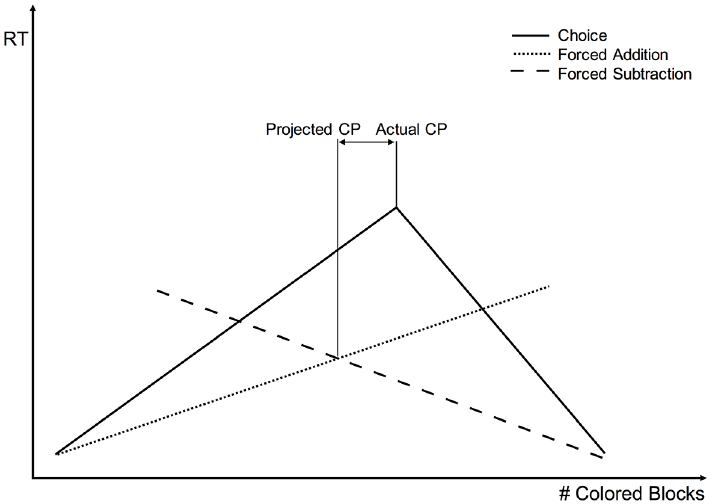
Figure 2. The calculation of the strategy adaptiveness measure. Note. RT = reaction time. CP = change point. The projected change point is the intersection of the regression lines of the Forced Addition condition and Forced Subtraction condition. The actual change point is the breakpoint of the Choice condition regression line. The strategy adaptiveness measure is the difference between the actual change point and the projected change